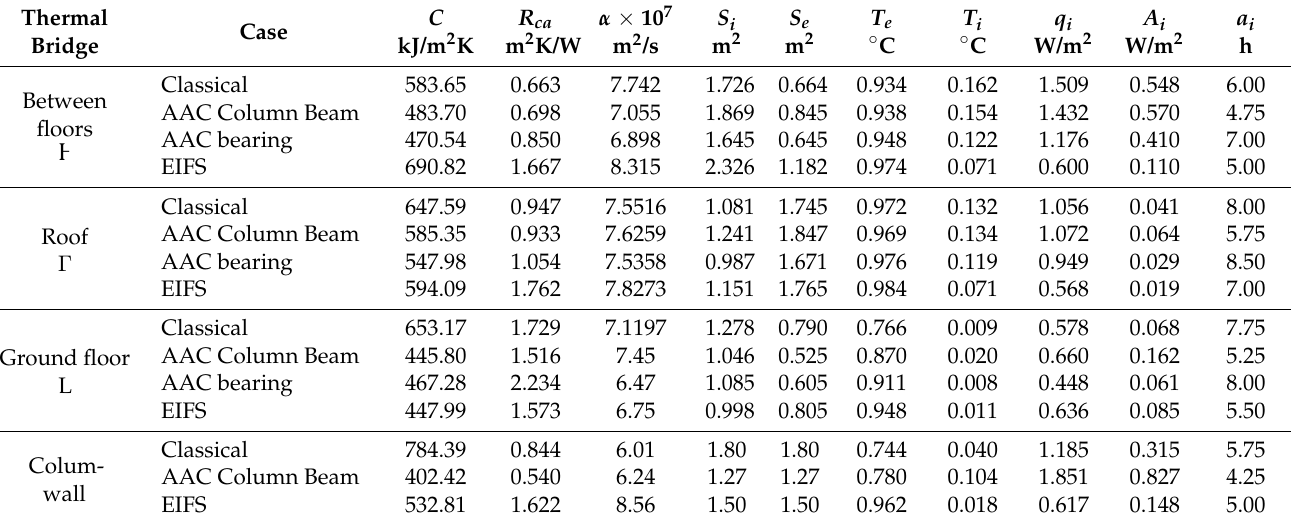
Table 4. The stationary and dynamic characteristics of the thermal bridges (obtained at standard temperature).